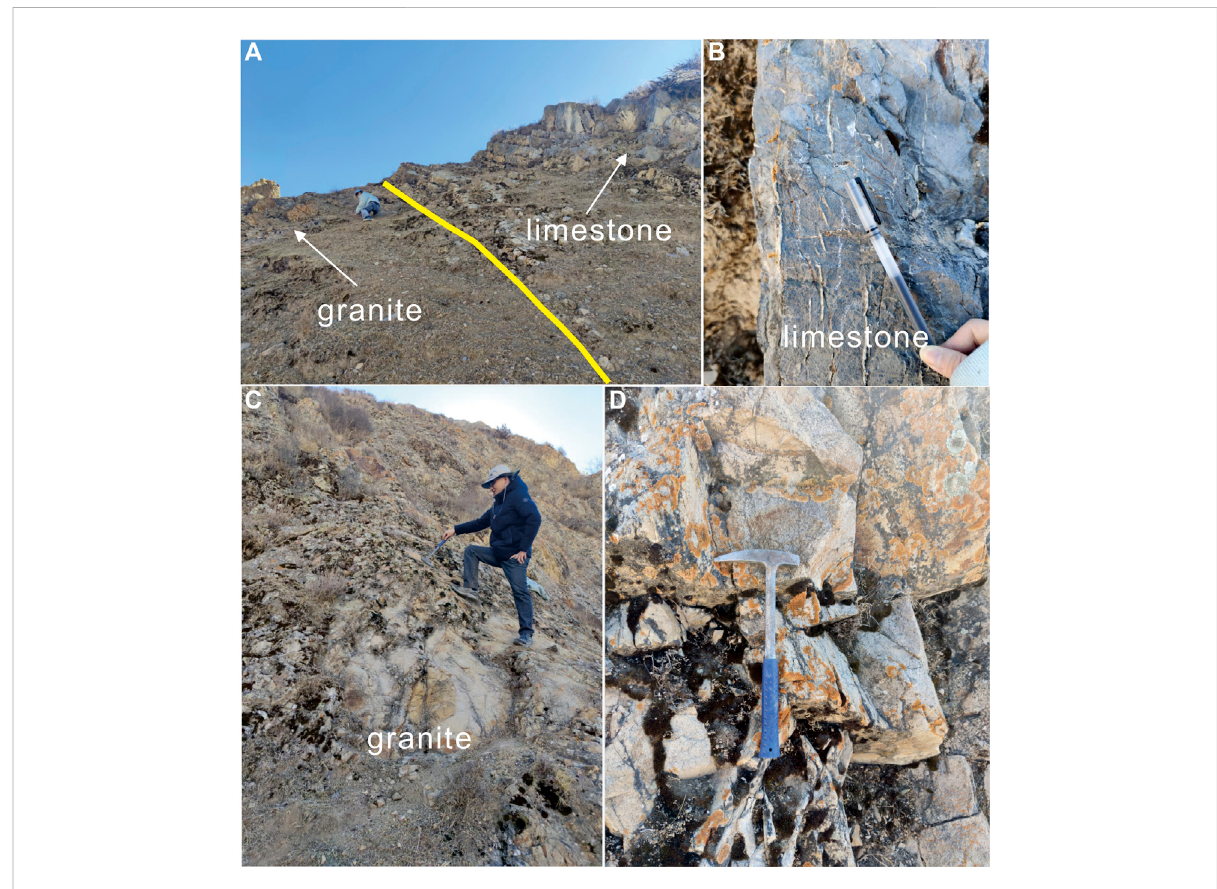
FIGURE 2 Field exposures of the studied granitic